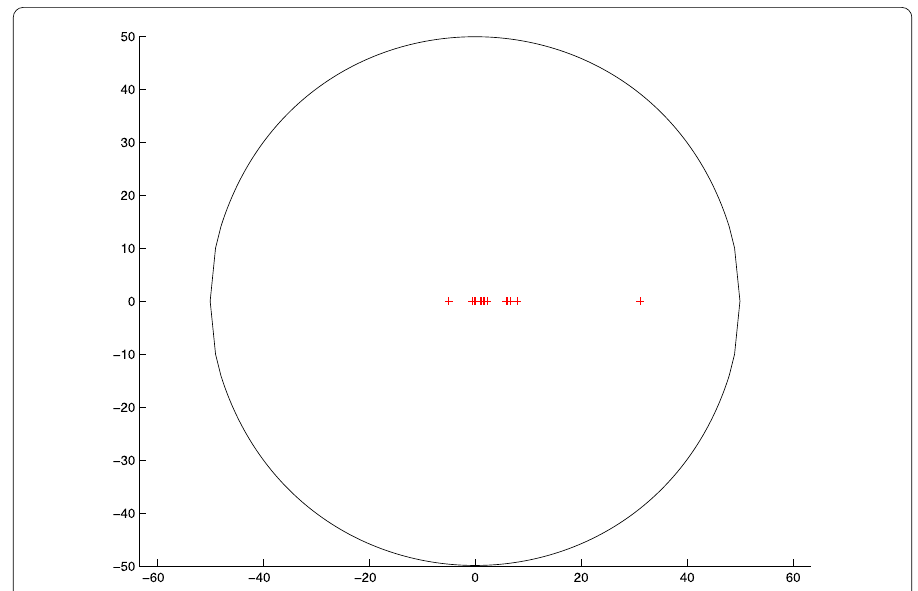
Figure 1 The singular value inclusion set ϒ S ( A ) and the exact singular